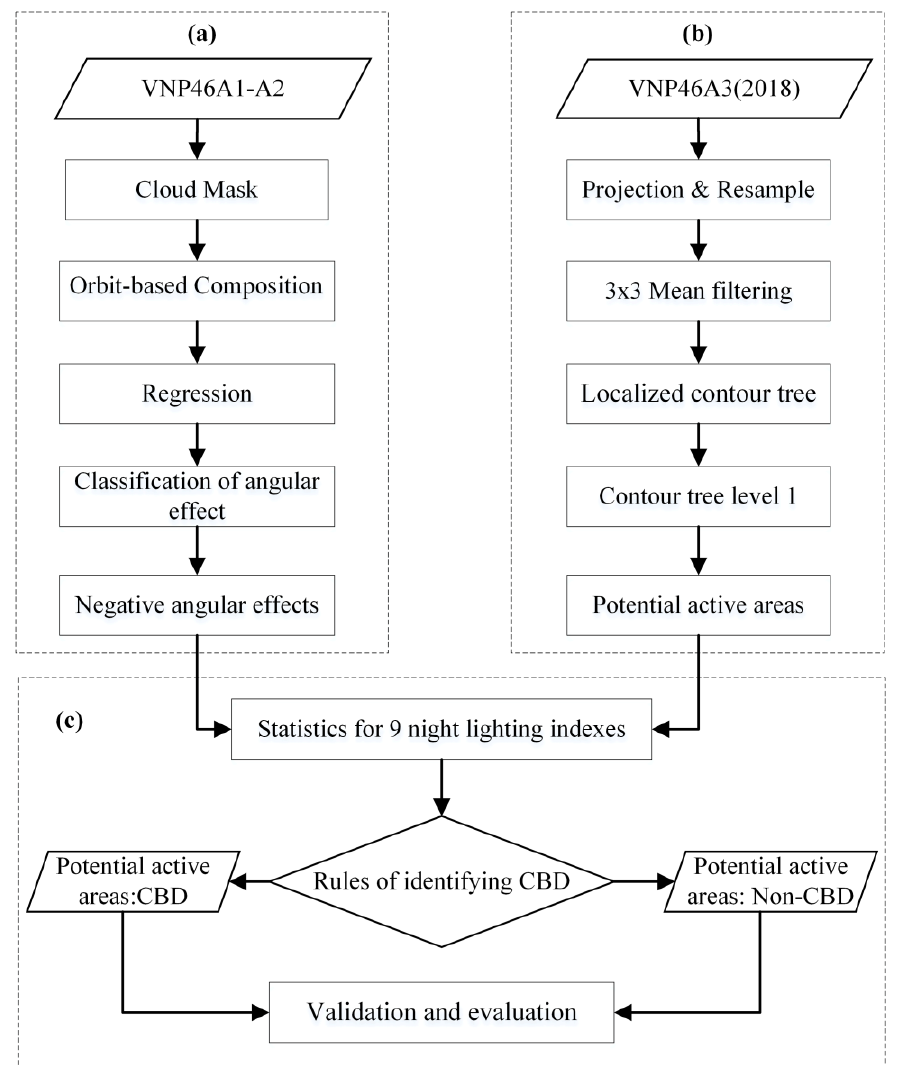
Figure 3. Workflow of NTL method for CBD delimitation. ( a ) Angular effect quantification and classification; ( b ) Using localized contour tree algorithm to acquire urban potential active areas; ( c ) Designing the rules for identifying CBD and